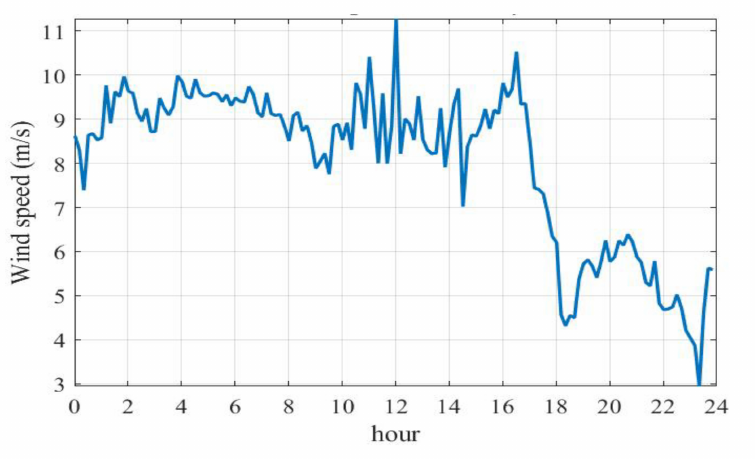
Figure 10. Measured wind speed throughout the